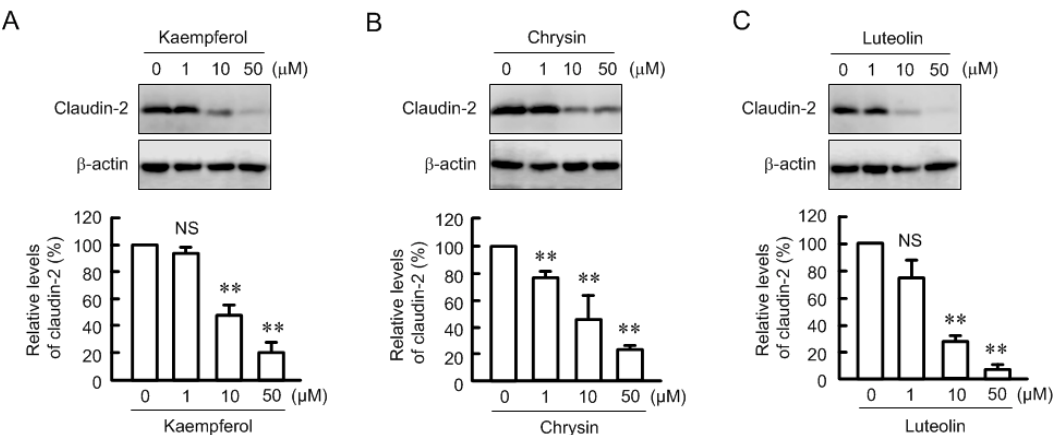
Figure 2. Dose-dependent effects of kaempferol, chrysin, and luteolin on claudin-2 expression. The cells were incubated in the absence and presence of kaempferol ( A ), chrysin ( B ), or luteolin ( C ) for 24 h at the concentration indicated. Cell lysates were immunoblotted with anti-claudin-2 or β -actin antibody. The expression levels of claudin-2 were represented relative to the values in 0 μ M. n = 3–4. ** p < 0.01 significantly different from 0 μ M. NS, not significantly different.